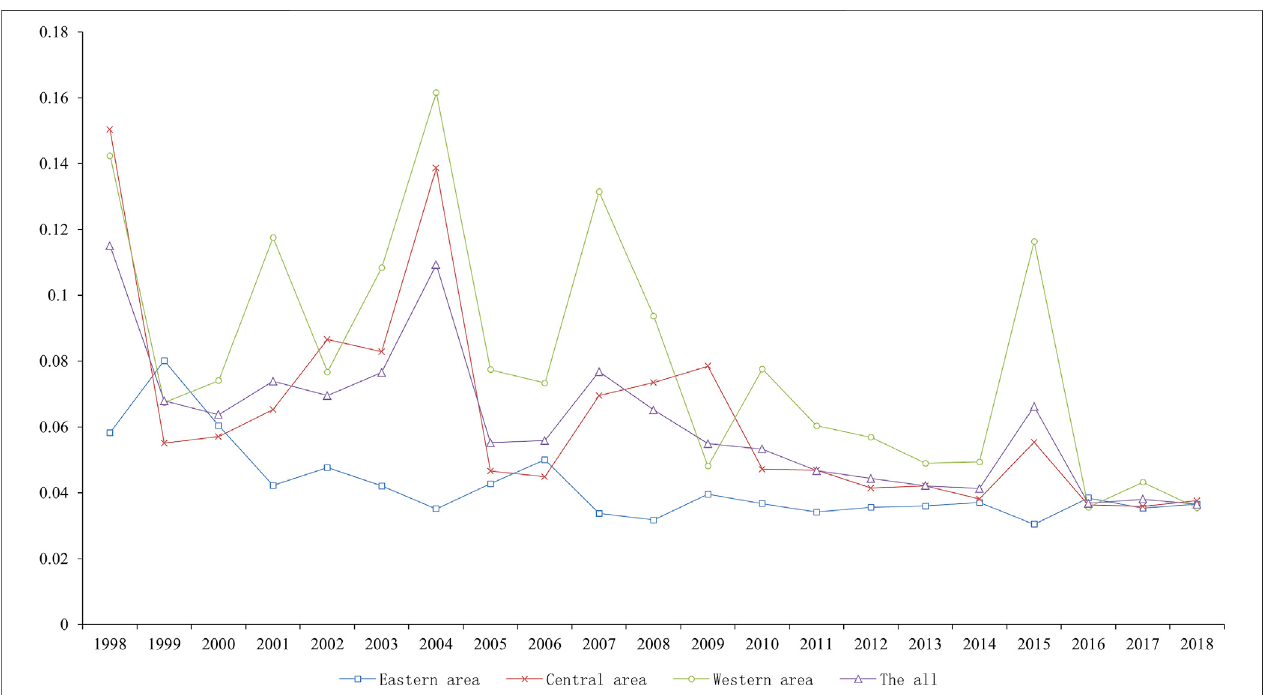
FIGURE 1 | The trend carbon by region of emission reduction potential change in agricultural green technological progress (1998 – 2018).